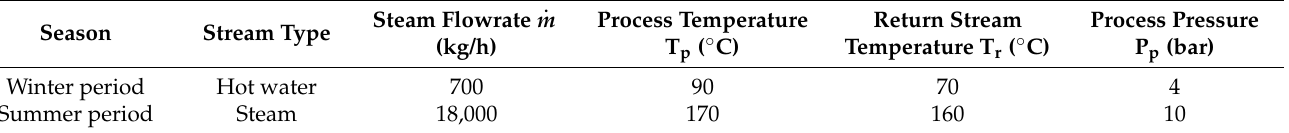
Table 1. Seasonal thermal demand for the current SHIP integration scheme in the Italian spirits industry. . m Steam Flowrate Season Stream Type